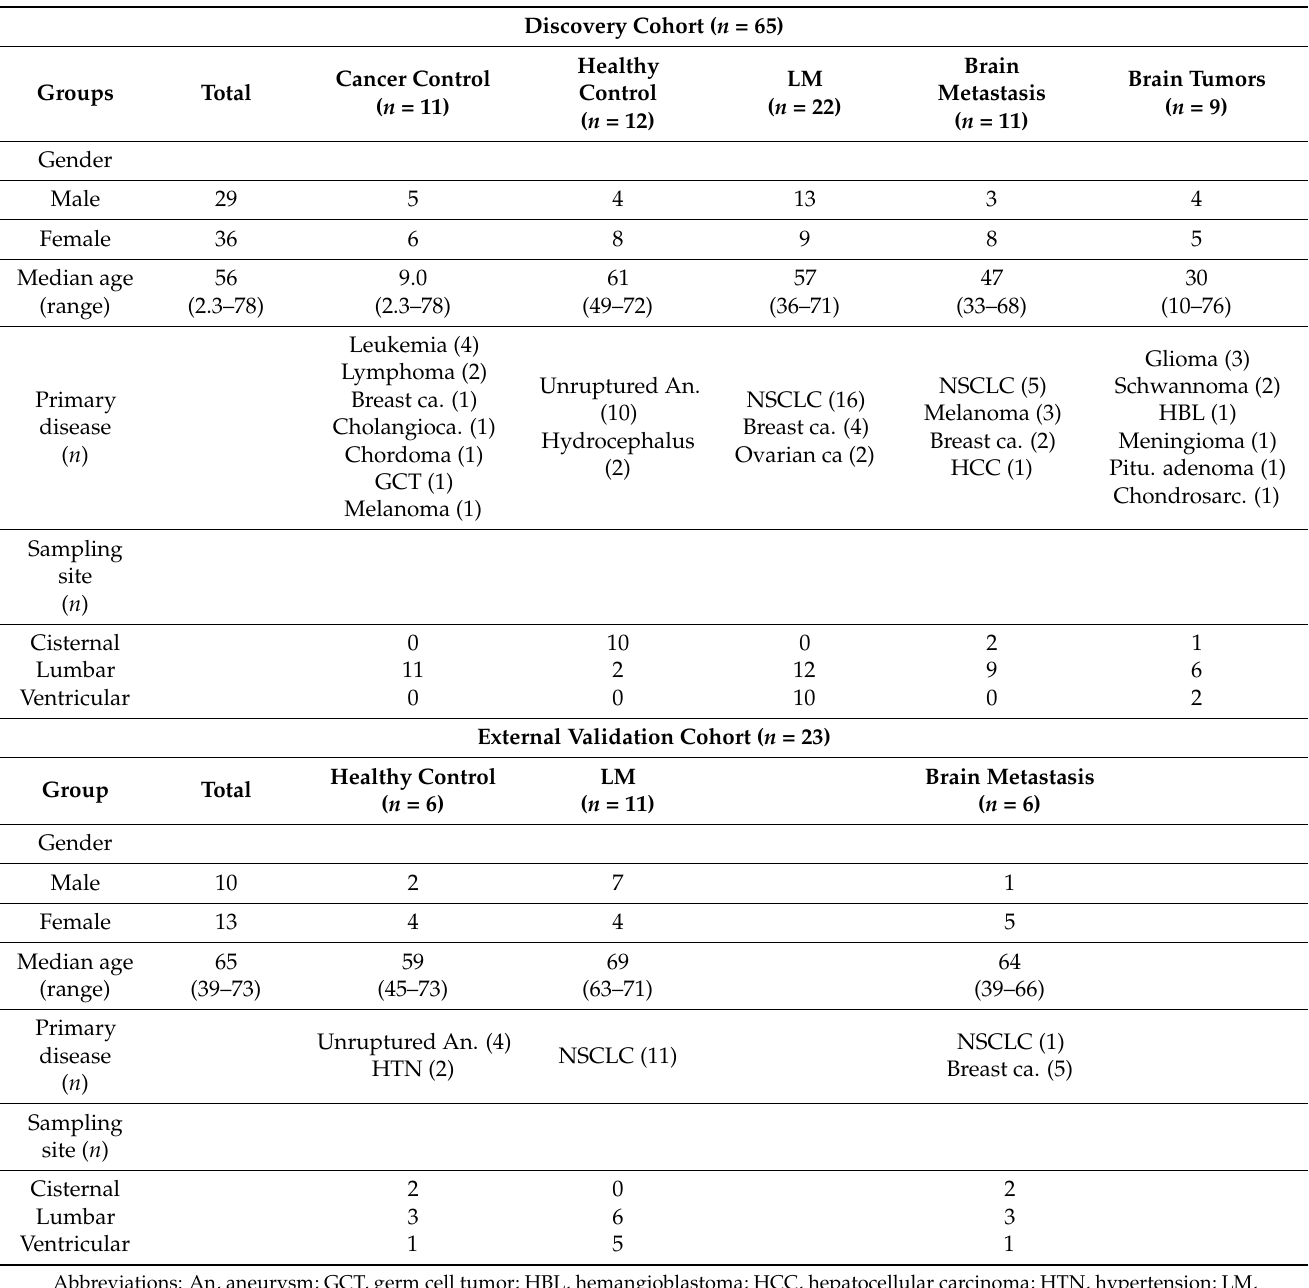
Table 1. Clinical characteristics of cerebrospinal fluid sample